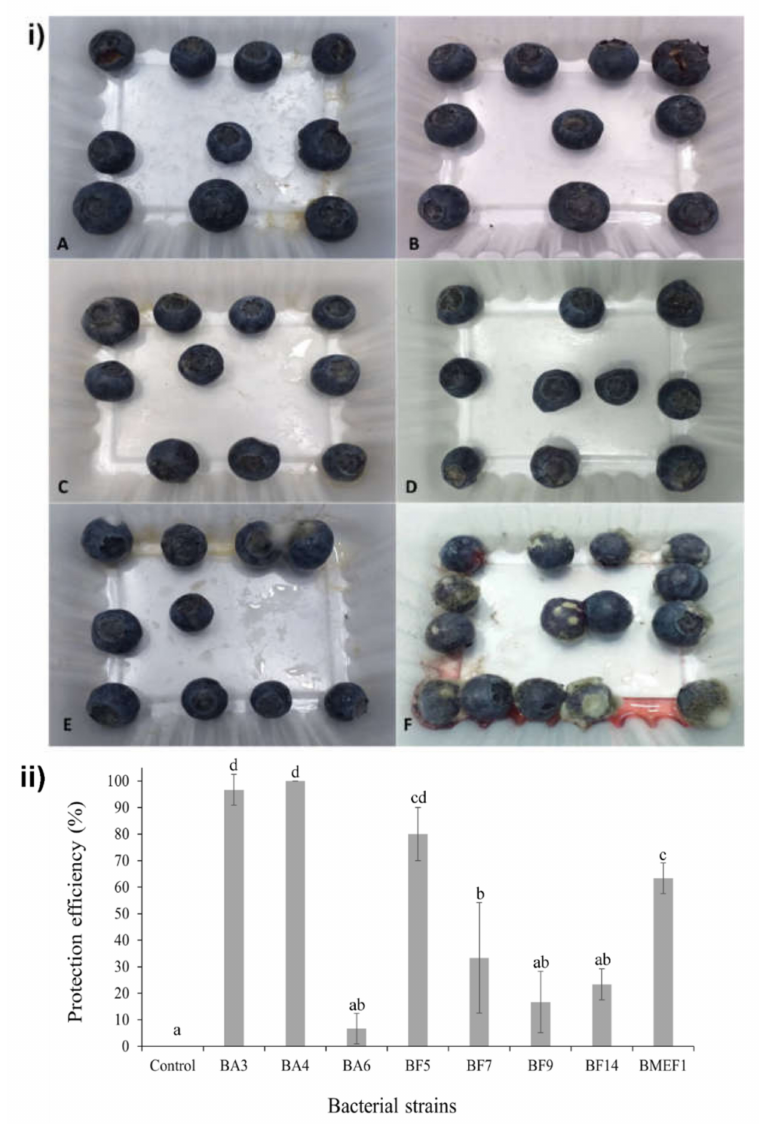
Figure 3. In vivo protection efficiency assay. ( i ) Blueberries artificially infected with B. cinerea after 7 days incubation at 25 ◦ C. Fruits were pretreated as described in Material and Methods with strains B. velezensis BA4 (A); B. velezensis BA3 (B), P. tremae BF5 (C), A. spathodeae BMEF1 (D), and M. testaceum BF7 (E), respectively. Control: fruits only inoculated with the pathogen (F). ( ii ) Protection